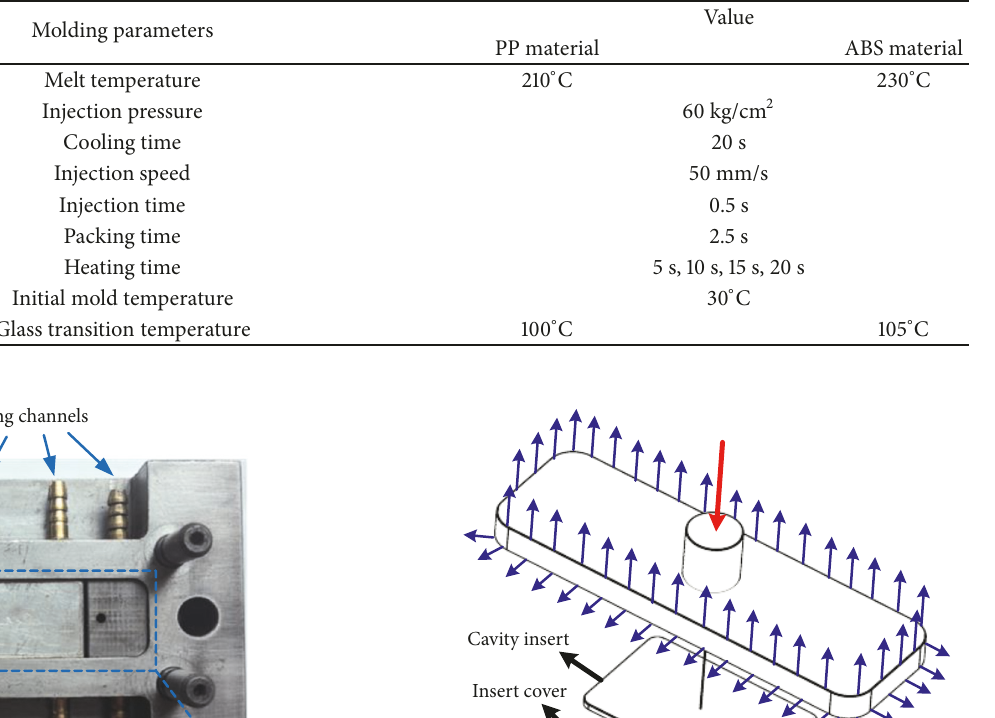
Table 3: Molding parameters for the melt flow length experiment.